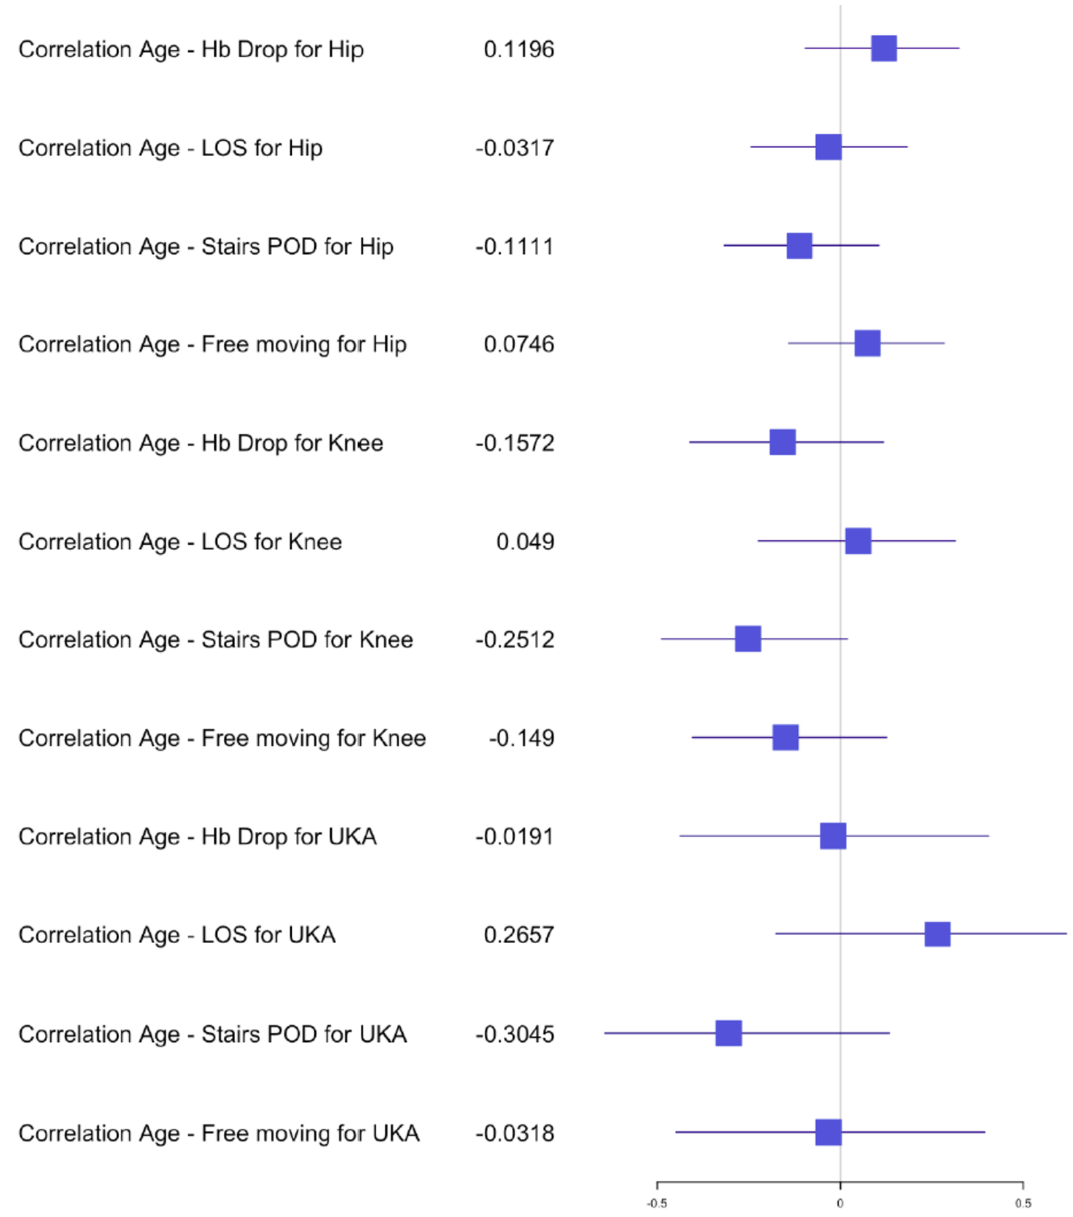
Figure 2. Forest plot for the effect of age on Hb drop, LOS (Length of stay) and functional outcome for simultaneous arthroplasty.